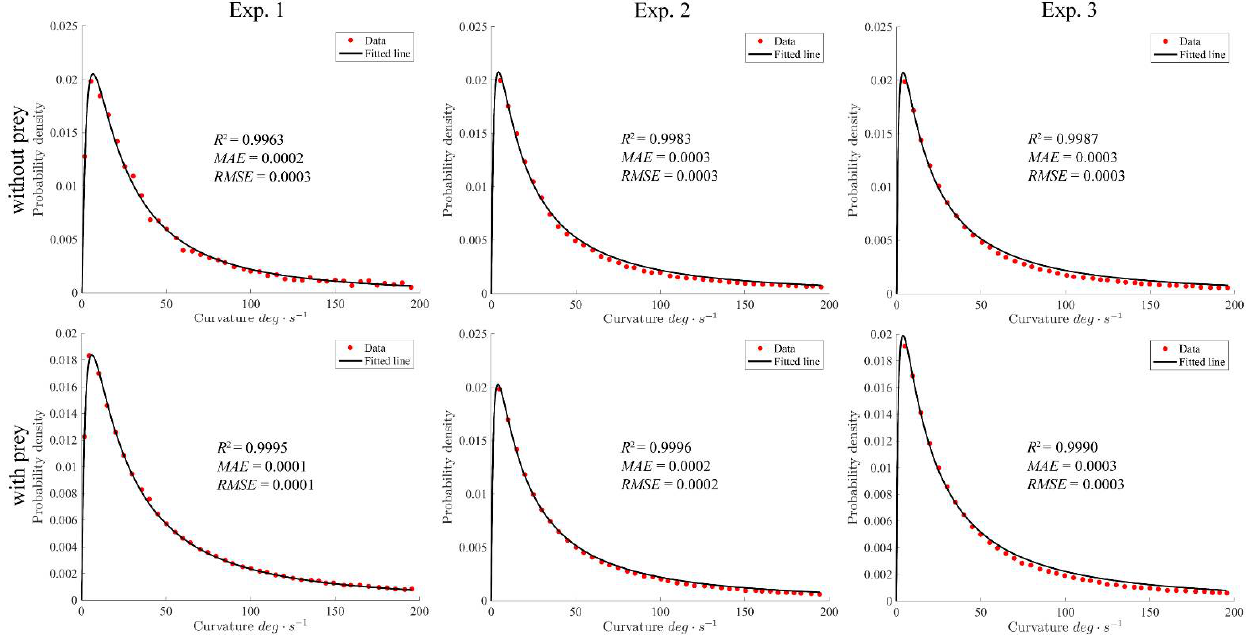
Figure 6. Fat tails in the frequency distributions of path curvature of O. marina before ( top ) and after ( bottom ) the introduction of a phytoplankton thin layer (Exp. 1 with either direct addition of the prey alga; Exp. 2&3 with cell-free filtrate). The red dots: original data; black line: fitted curve using log-normal distribution formula.